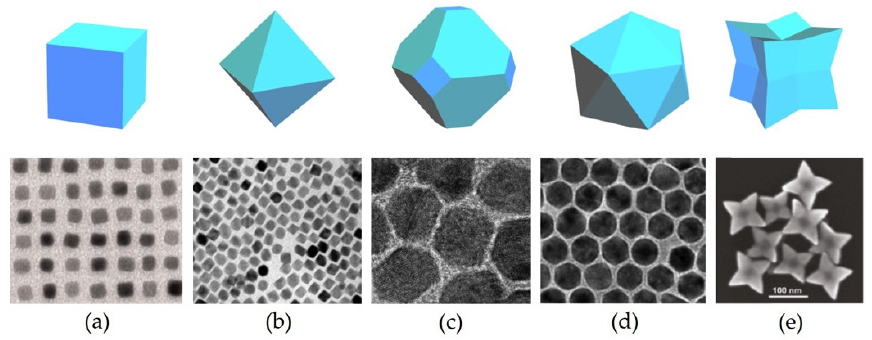
Figure 2. Illustrative models of ( a ) cubes; ( b ) octahedral; ( c ) truncated octahedral; ( d ) icosahedra; and ( e ) concaved polyhedra and their representative transmission electron microscopy (TEM) or